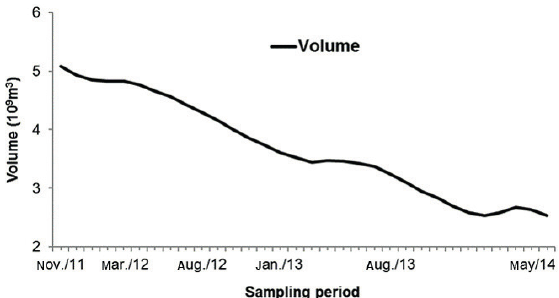
Figure 4 - Variation of the reservoir volume relative to its maximum safe operation capacity, between 2010 and 2015 in the Castanhão Reservoir (COGERH